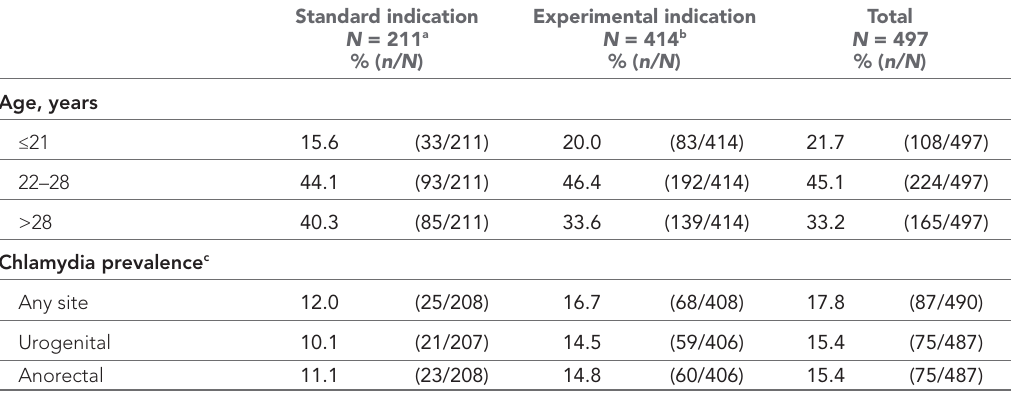
Table 1 Population characteristics and Chlamydia trachomatis prevalence by indication for